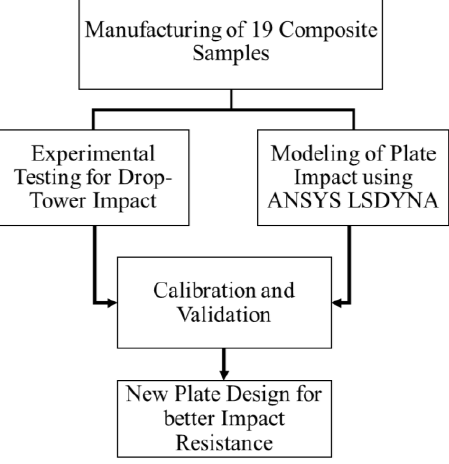
Figure 1. Flowchart for the entire experimental and modeling procedure in this study.